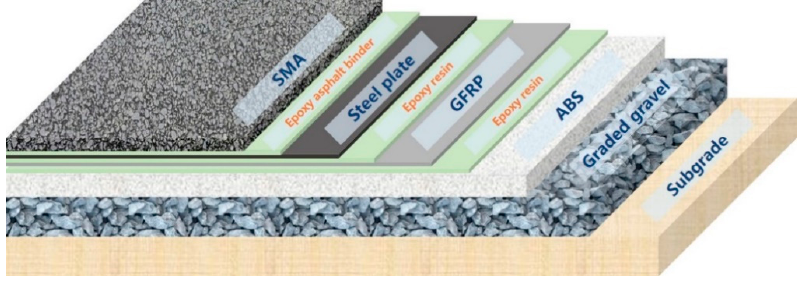
Figure 2. Proposed materials for ASP pavement structural layer. Table 2. Properties of SBS modified asphalt binder. Table 3. Gradation of SMA for testing.